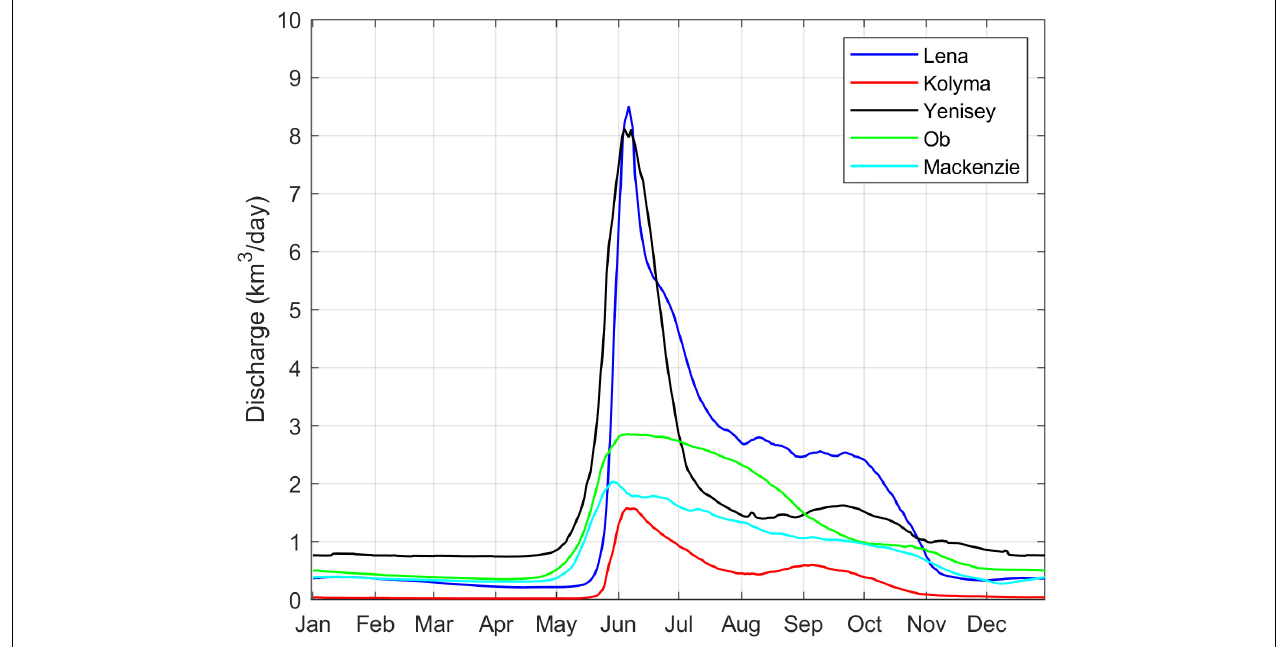
FIGURE 2 | Mean (1999–2019) daily river discharge from the major Arctic rivers (in km 3 day − 1 ) from ArcticGRO (Shiklomanov et al.,